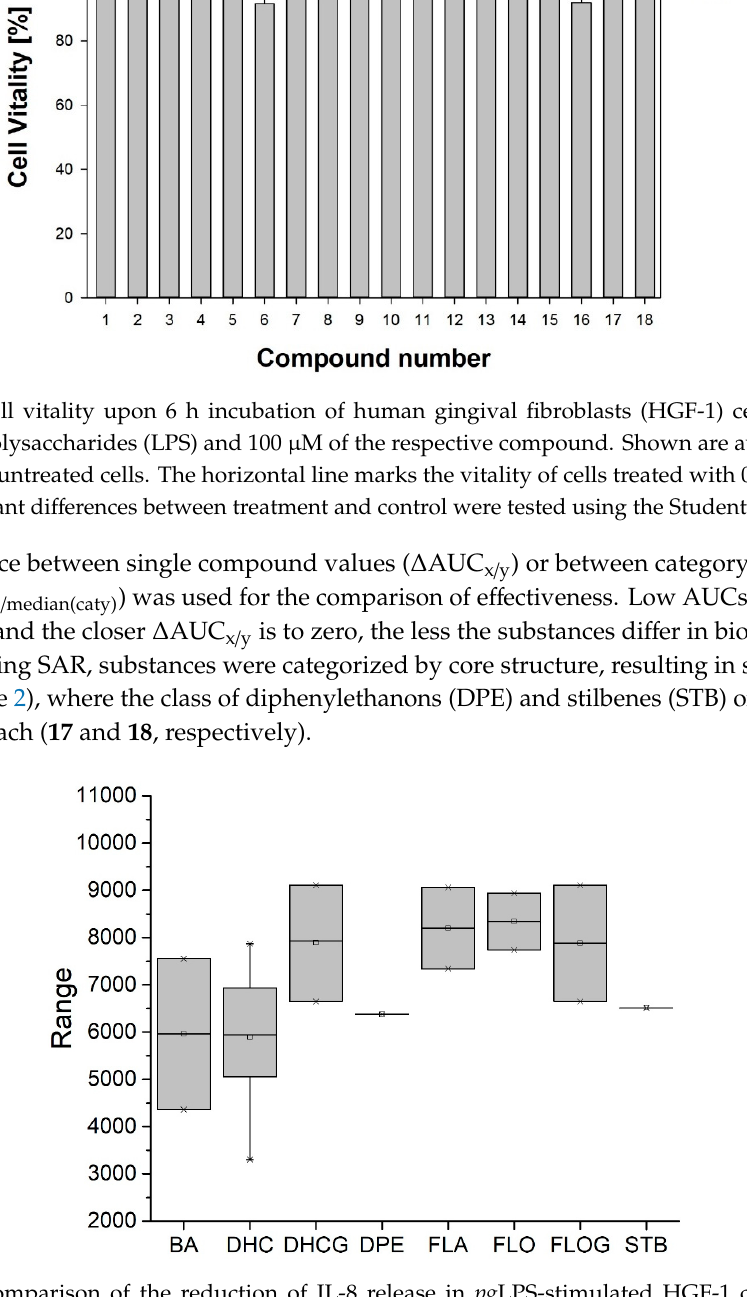
Figure 2. Comparison of the reduction of IL-8 release in pg LPS-stimulated HGF-1 cells among groups of the tested compounds (1 to 18) with different core scaffolds. Depicted are boxplots (min, Q 0.25 , median, Q 0.75 , max) of the individual AUCs in the substance groups. Substance groups are N-benzyl-benzamides (BA; n = 2; compounds 13 and 14 , AUC median = 5928), dihydrochalcones (DHC; n = 7; 6 – 12 , AUC median = 5738), dihydrochalcone glycosides (DHCG; n = 3; 1 – 3 , AUC median = 7766), diphenylethanone (DPE; n = 1; 17 , AUC = 6378), flavans (FLA; n = 2; 15 and 16 , AUC median = 8090), flavanones (FLO; n = 2; 4 and 5 , AUC median = 8105), and stilbenoid (ST; n = 1; 18 , AUC = 6512). Considering only groups with at least two compounds, Dihydrochalcones (DHC, n = 7, AUC median = 5738) and N -benzylamides (BA, n = 2, AUC median = 5928) exhibited the most potent effects, as depicted in Figure 2.